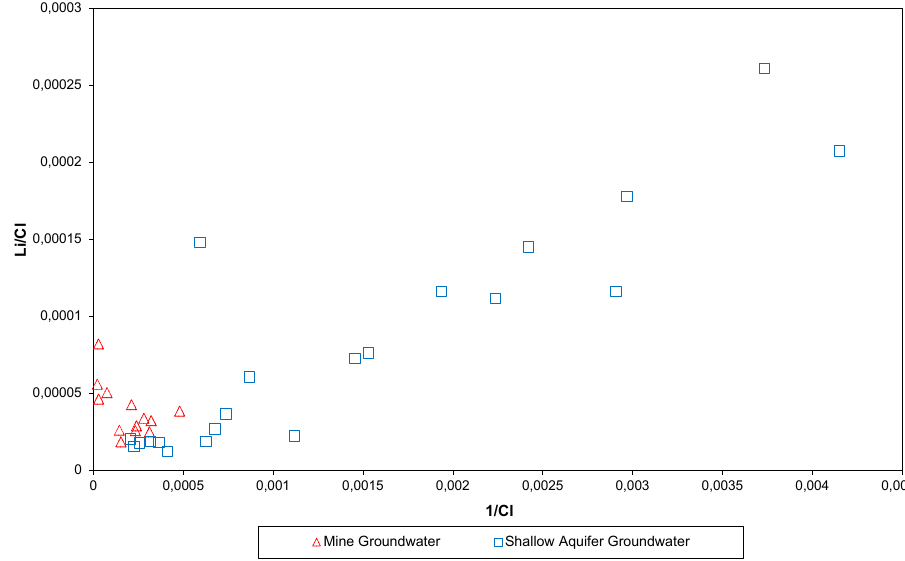
Figure 7. Plot of 1/Cl − versus Li + /Cl − (weighted) of shallow aquifer and mine groundwater.